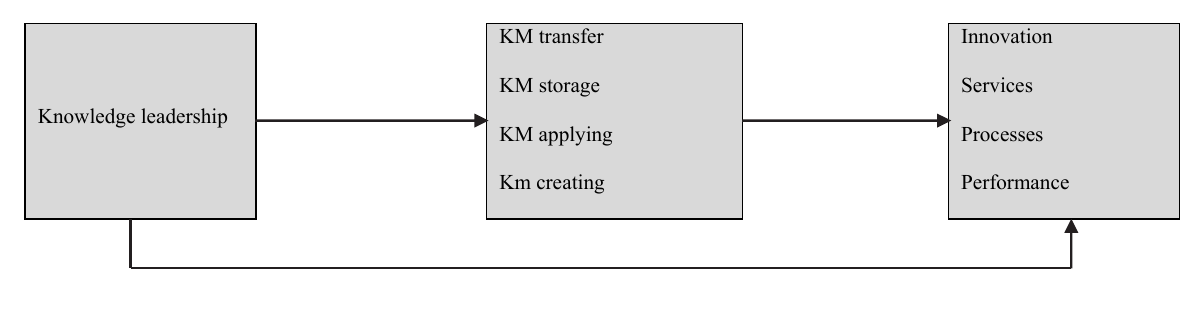
Fig. 1. The proposed study of this